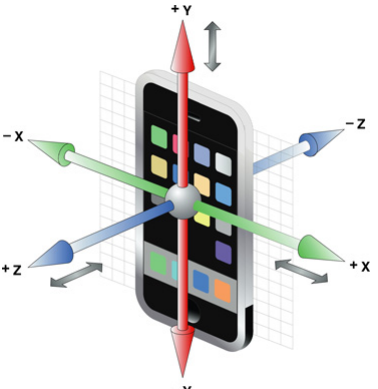
Figure 1. Smartphone coordinate